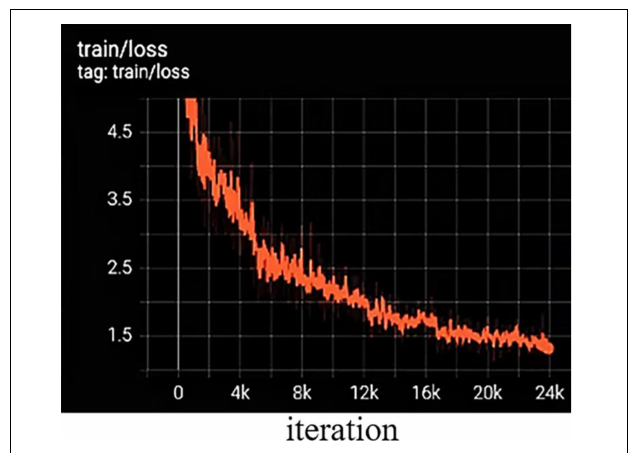
FIGURE 7 | Training error variation